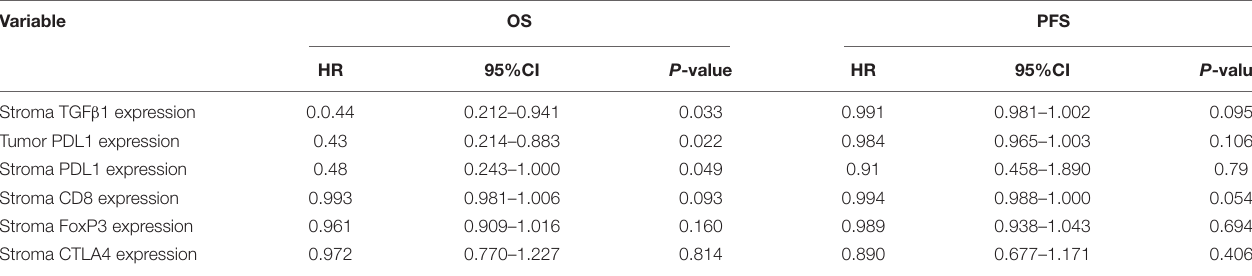
FIGURE 1 | Prognostic role of TGF β 1 impact on OS and PFS in overall SCLC patients (A) ; and in patients receiving radiation therapy (B) . OS, overall survival; PFS, progression-free survival. TABLE 3 | Univariate Cox regression analysis about the impact of immune indicators on OS and PFS of patients with SCLC.